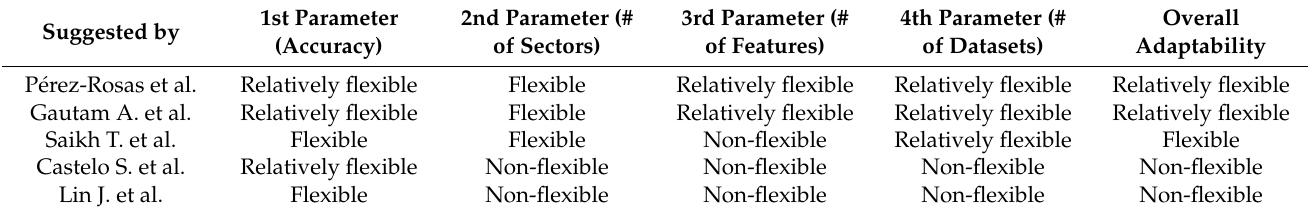
Table 7. Adaptability of Cross-Domain